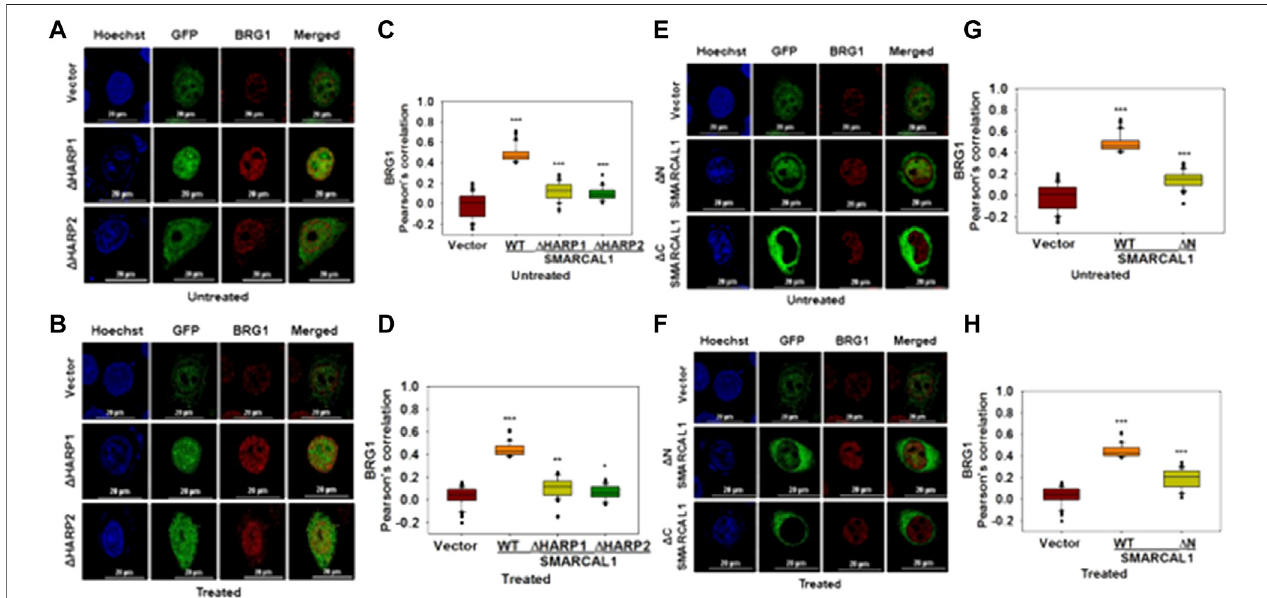
FIGURE 4 | HARP domains of SMARCAL1 are required for interaction with BRG1 (A) . Co-localization of GFP- Δ HARP1 and GFP- Δ HARP2 with BRG1 in the absence of doxorubicin treatment (B) . Co-localization of GFP- Δ HARP1 and GFP- Δ HARP2 with BRG1 in the presence of 2 μ M doxorubicin treatment for 10 min (C) . Pearson ’ s coef fi cient for the interaction of GFP- Δ HARP1 and GFP- Δ HARP2 with BRG1 in the absence of doxorubicin treatment (D) . Pearson ’ s coef fi cient for the interaction of GFP- Δ HARP1 and GFP- Δ HARP2 with BRG1 in the presence of 2 μ M doxorubicin treatment for 10 min (E) . Co-localization of GFP- Δ N and GPF- Δ C with endogenous BRG1 in the absence of doxorubicin treatment (F) . Co-localization of GFP- Δ N and GPF- Δ C with endogenous BRG1 in the presence of 2 μ M doxorubicin treatment for 10 min (G) . Pearson ’ s coef fi cient for the interaction of GFP- Δ N and GFP- Δ C with endogenous with BRG1 in the absence of doxorubicin treatment (H) . Pearson ’ s coef fi cient for the interaction of GFP- Δ N and GFP- Δ C with endogenous with BRG1 in the presence of doxorubicin treatment. In all these experiments,HeLacellsweretreatedwith2 μ Mdoxorubicinfor10 minandn ≥ 40cellswereanalyzed.Starindicatessigni fi cancewith* p -value < 0.05,** p -value < 0.005, *** p value < 0.0001. The wild-type data used in the analysis has been shown in Figure 2 . The scale in the images is 20 μ